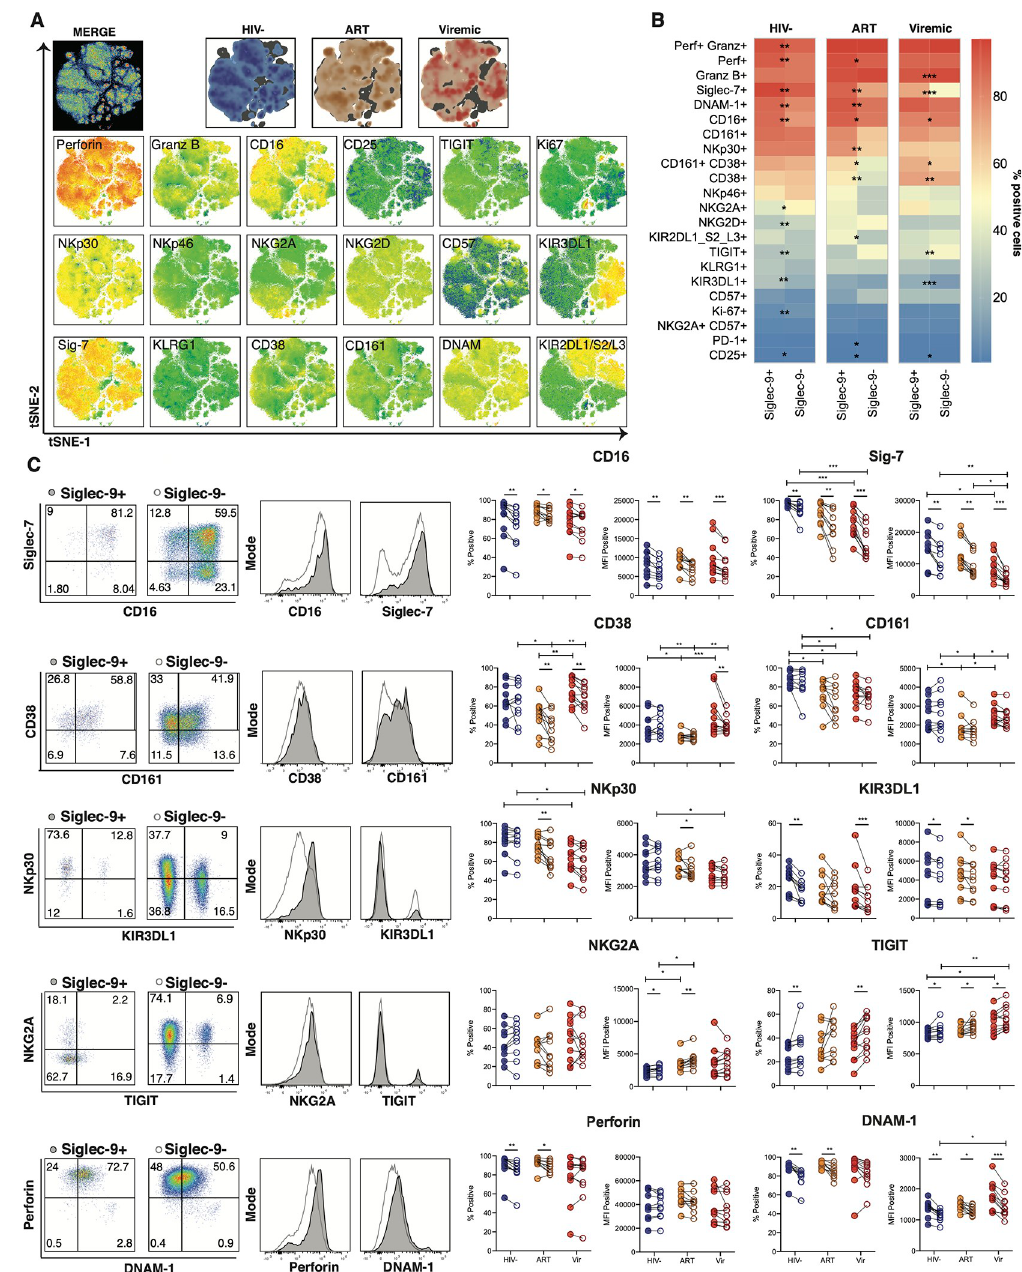
Fig 2. The phenotype of Siglec-9 + CD56 dim NK cells. (A) Global t-SNE visualization of Siglec-9 + CD56 dim NK cells for all individuals pooled, with Siglec-9 + CD56 dim NK cells from HIV-, HIV+ ART+, and HIV+ viremic individuals concatenated and overlayed (dimensionality reduction performed from 234,000 cells in 21 dimensions, 10,000 iterations, excluding parameters used to define the population: time, FSC, SSC, viability, CD14, CD19, CD3, and Siglec-9). Bottom: t-SNE projections of the 18 indicated proteins expression. (B) Heatmaps showing the percentages of Siglec-9 + and Siglec-9 - CD56 dim NK cells expressing the indicated activation and inhibitory markers in HIV-, HIV+ ART+, and HIV+ viremic individuals. (C) Comparative analyses of frequency (% positive) and expression (MFI of the positive population) of CD16, Siglec-7, CD38 CD161, NKp30, KIR3DL1, NKG2A, TIGIT, Perforin, and DNAM-1 on Siglec-9 + vs. Siglec-9 - CD56 dim NK cells. Left: Representative flow plots and histograms from HIV+ ART-suppressed donors are shown. Numbers inside the plots represent the gated percentage within the parent population. Mann-Whitney rank test was used to compare between groups. Paired Wilcoxson test was used to compare Siglec-9 + and Siglec-9 - within each group. ��� p < 0.001, �� p < 0.01, � p < 0.05. n = 10 HIV- negative controls, 11 HIV+ viremic, and 10 HIV+ on suppressive ART.